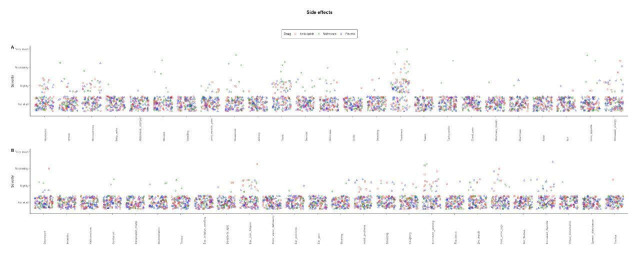
Nausea and other possible side effects were measured through self-report (4 options: “not at all”, “slightly”, “moderately”, and “very much“) three hours after pill intake.All reported side effects were generally low, and did not differ between groups. The list of side effects (from top left to bottom right in the figure; original in German) was: headache; unrest; nervousness; belly ache; abdominal cramps; nausea; vomiting; joint/muscle pain; weakness; anxiety; thirst; swindle; dizziness; chills; sweating; tiredness; tears; tachycardia; chest pain; shortness of breath; diarrhoea; rush; itch; loss of appetite; increased energy; depressed; irritability; hallucinations; confusion; persecution mania; disorientation; tremor; eye irritation/swelling; light sensitivity; eye pain/fatigue; color vision deficiency; ear problems; ear pain; blushing; nasal problems; sneezing; coughing; increased yawning; flatulence; dry mouth; cold arms/legs; hot flashes; increased appetite; visual disturbance; speech disturbance; tinnitus.